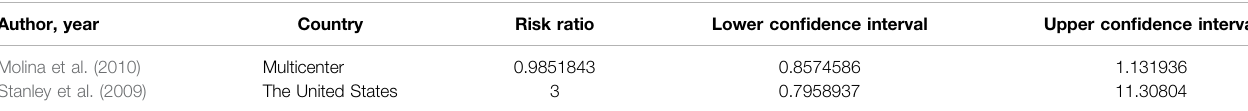
TABLE 3 | Adverse events. Author,